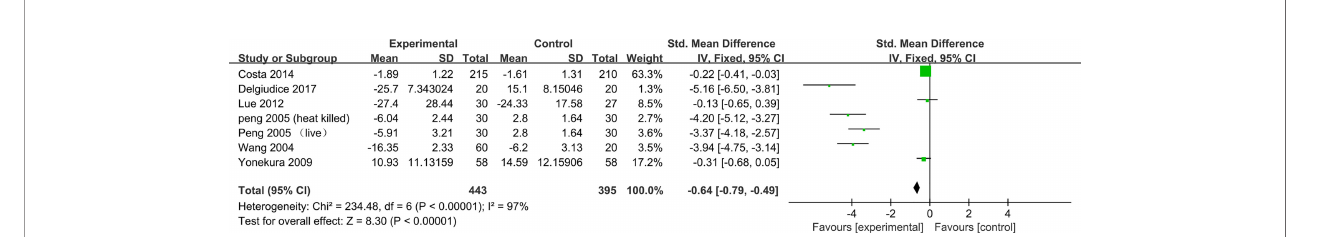
FIGURE 5 | Forest plot for Rhinoconjunctivitis Quality of Life Questionnaire